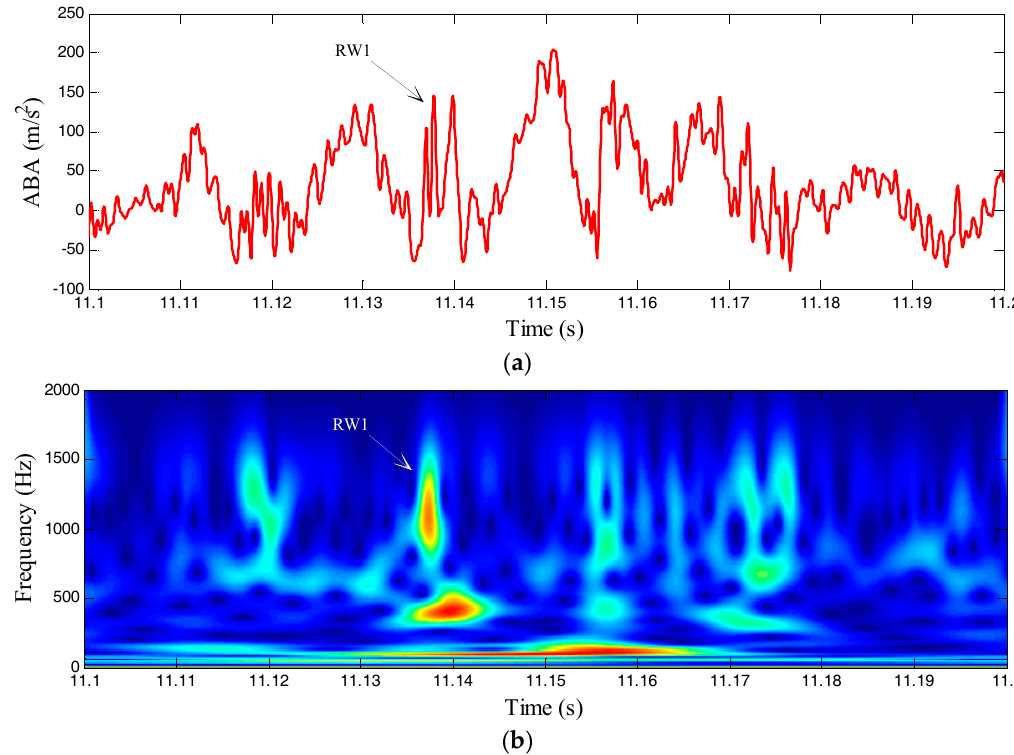
Figure 5. The response of ABA in ( a ) time and ( b ) time–frequency domain when a vehicle passes the rail welds at a speed of 300 km/h on a certain high-speed line.